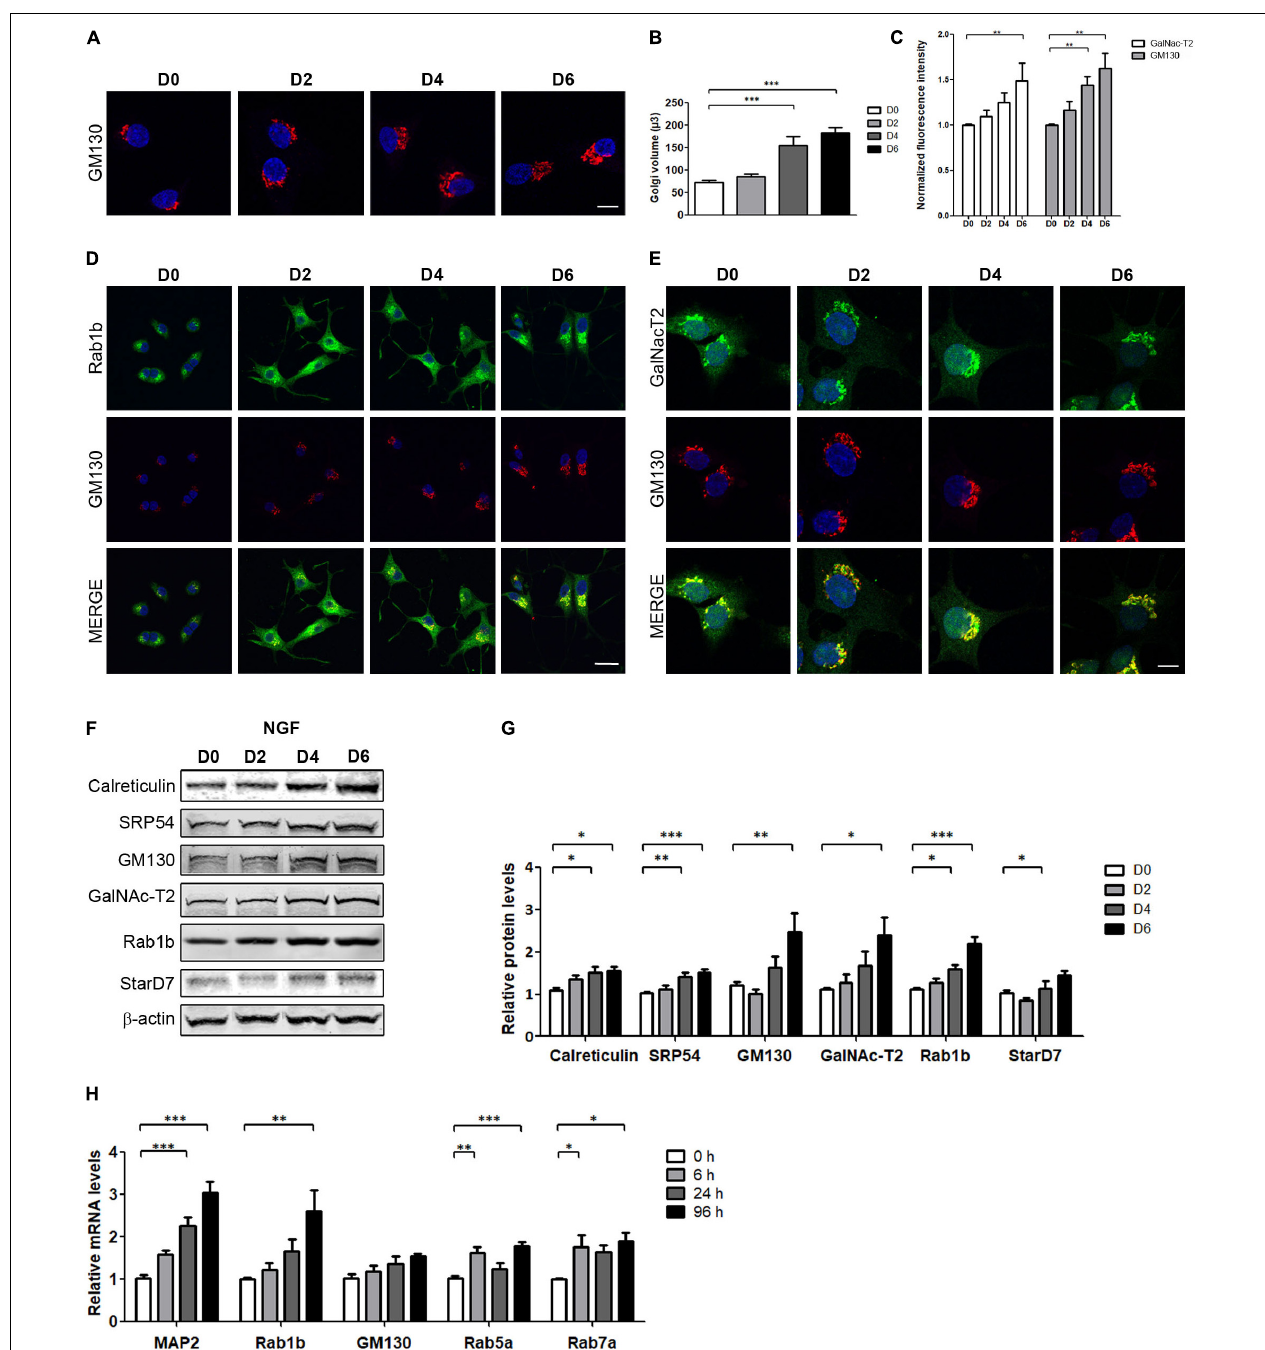
FIGURE 1 | NGF-induced PC12 cell differentiation increases Golgi volume and transport proteins. (A,D,E) Immunofluorescence performed in PC12 cells differentiated with NGF (100 ng/ml) during the indicated days and stained with the specified markers. Nuclei were stained with Hoechst (blue). (A,C) The Golgi complex was labeled with GM130 (red, Bar: 8 µ m) and the normalized fluorescence intensity was plotted (a total of 60 cells were analyzed). (B) Golgi volume was quantified on the indicated days. Fiji-ImageJ software was used to perform three-dimensional reconstruction and quantification of the images. (D,E) Rab1b, GM130, and GalNAc-T2 staining. Scale bars: 20 and 8 µ m, respectively. (F) Representative Western blot assays performed with cell lysates obtained from PC12 cells differentiated with NGF during the indicated days (D2, D4, and D6). (G) Densitometric quantification of proteins shown in (F) normalized to β -actin. Values represent fold change relative to protein levels in untreated cells (D0). (H) Quantification of the indicated genes by qRT-PCR performed with total RNA during the indicated times. Results were normalized to the levels of TBP and expressed according to the 2 − (cid:49)(cid:49) Ct method relative to the expression level of each gene in untreated cells (0 h, set as 1). Bars represent the mean ± SEM of three independent experiments carried out in triplicates. (B,C,G,H) Statistical data analysis were performed using ANOVA test, followed by Bonferroni multiple comparison post-test, considering statistically significant a value of p < 0.05 ( ∗ p < 0.05; ∗∗ p < 0.001; ∗∗∗ p < 0.0001).